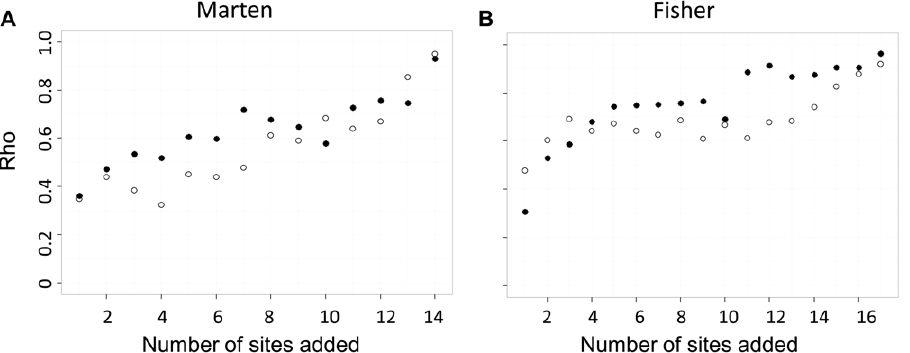
Figure 5. The effect of unsampled sites on the rank-order of cGD as measured by Spearman ’ s r . Higher values of r indicate fewer deviations in the rank order of cGD compared between each iteration and the true cGD . Each iteration represents the addition of one site to the analysis; hollow symbols represent the addition of the least connect sites and filled symbols represent the addition of the most connected sites. doi:10.1371/journal.pone.0056204.g005 PLOS ONE |